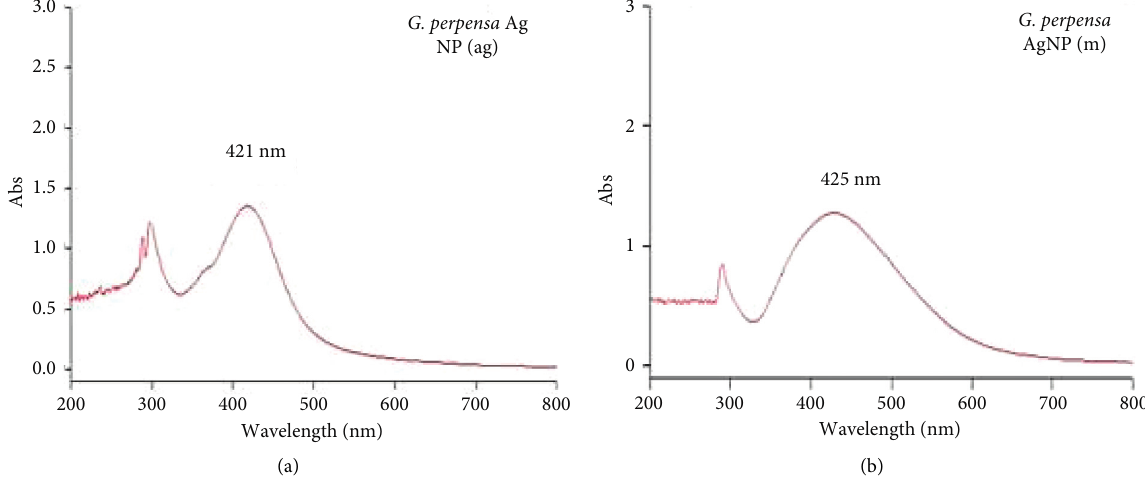
Figure 1: Positive colour change results for aqueous and methanolic extract reaction with 1mM AgNO before mixing with the extract; (b) after mixing the AgNO 3 solution with the extract, yellowish-brown colour appeared, and the colour changed to brown after 3h.